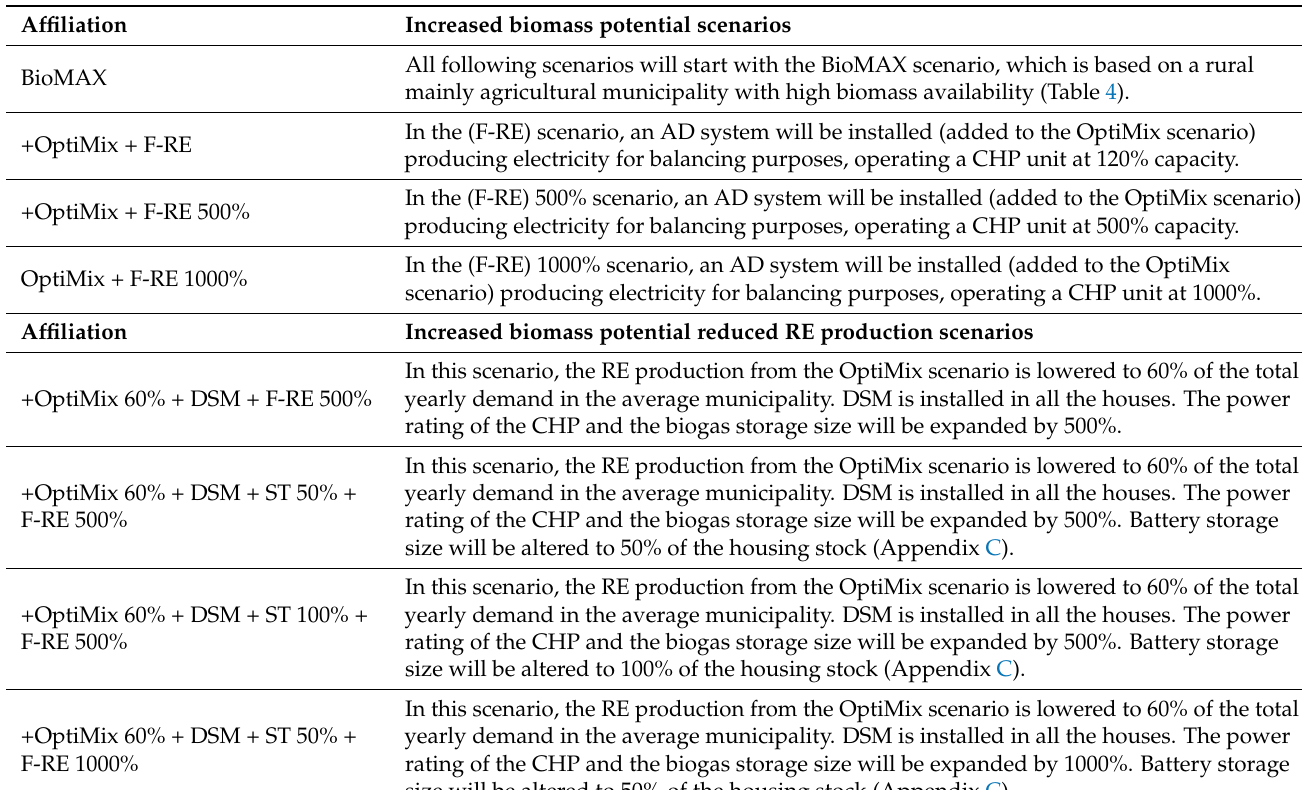
Table A23. BioMAX scenarios.